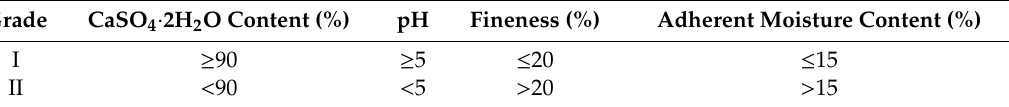
Table 11. Classification of road usage